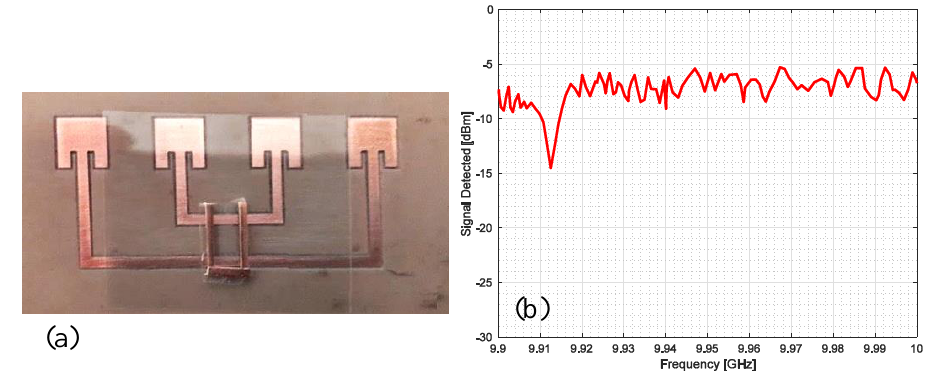
Figure 15. ( a ) Photograph of a single-bit chipless Van Atta array RFID prototype fabricated on an FR4 dielectric substrate and equipped with a C resonator placed vertically with respect to the connection microstrip. ( b ) Measured signal from the prototype reported in ( a ).